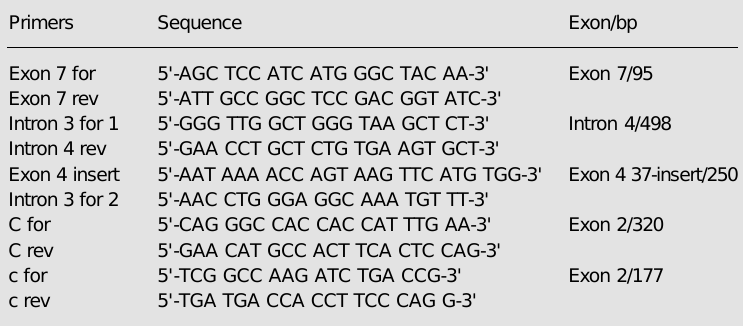
Table 2. Primers used for identification of RHD-CE-D s